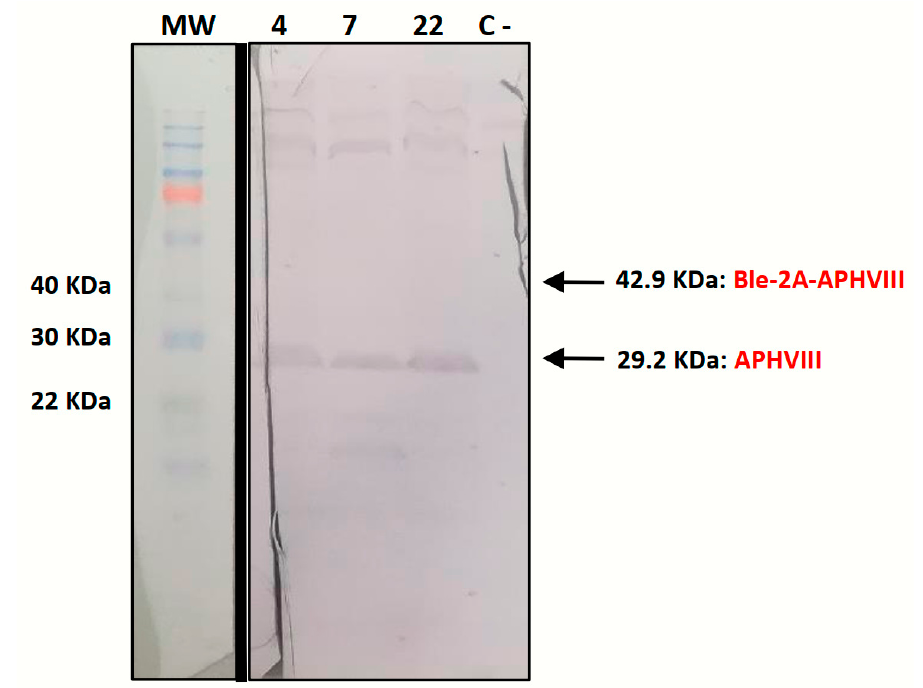
Figure A3. Inmunoblot analysis showing the APHVIII protein in the full-length blot. Total protein extracts (60 µg) were fractionated with SDS-PAGE, transferred to a PVDF membrane and probed with rabbit anti-APHVIII polyclonal antibodies and alkaline phosphatase-conjugated goat anti-rabbit IgG, as indicated in 3.4 materials and methods. MW, contains molecular weight markers; #4, #7 and #22 corresponding to three Chlamydomonas transformants and C-, one control untransformed Chlamydomonas culture. Table A1. Oligonucleotides used in this work for quantitative RT-PCR experiments.